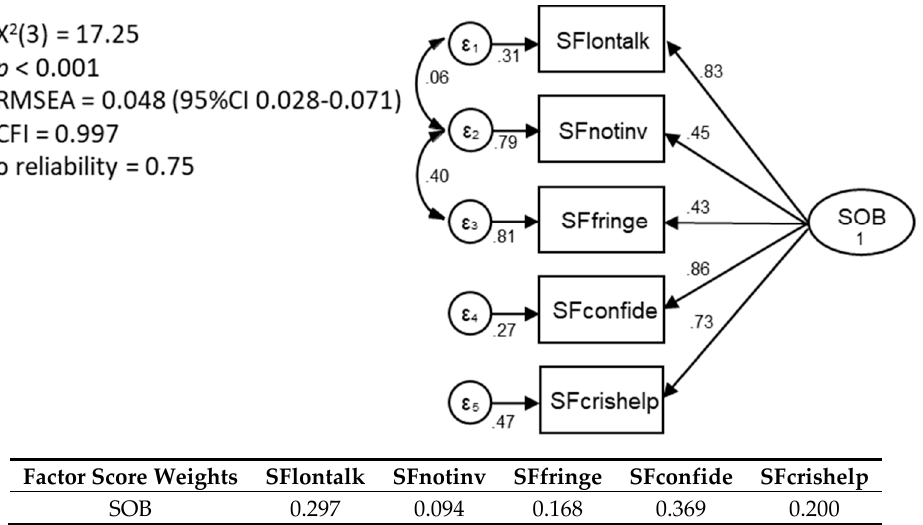
Figure A3. Final model for Sense of Belonging construct of personal social cohesion.